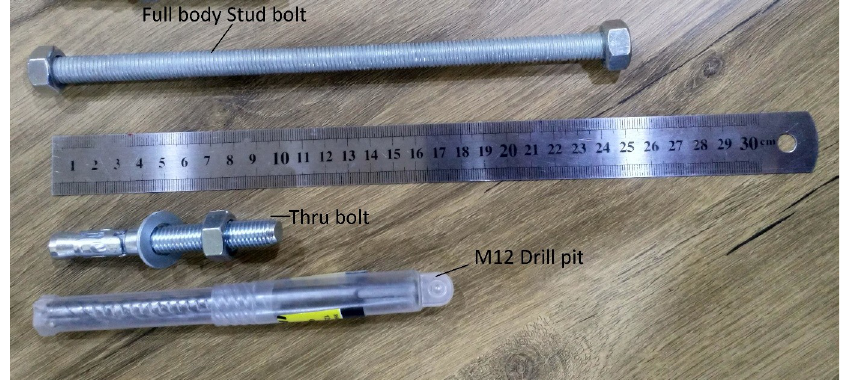
Fig 15. Bolt types tested with the drill pit used in drilling the concrete